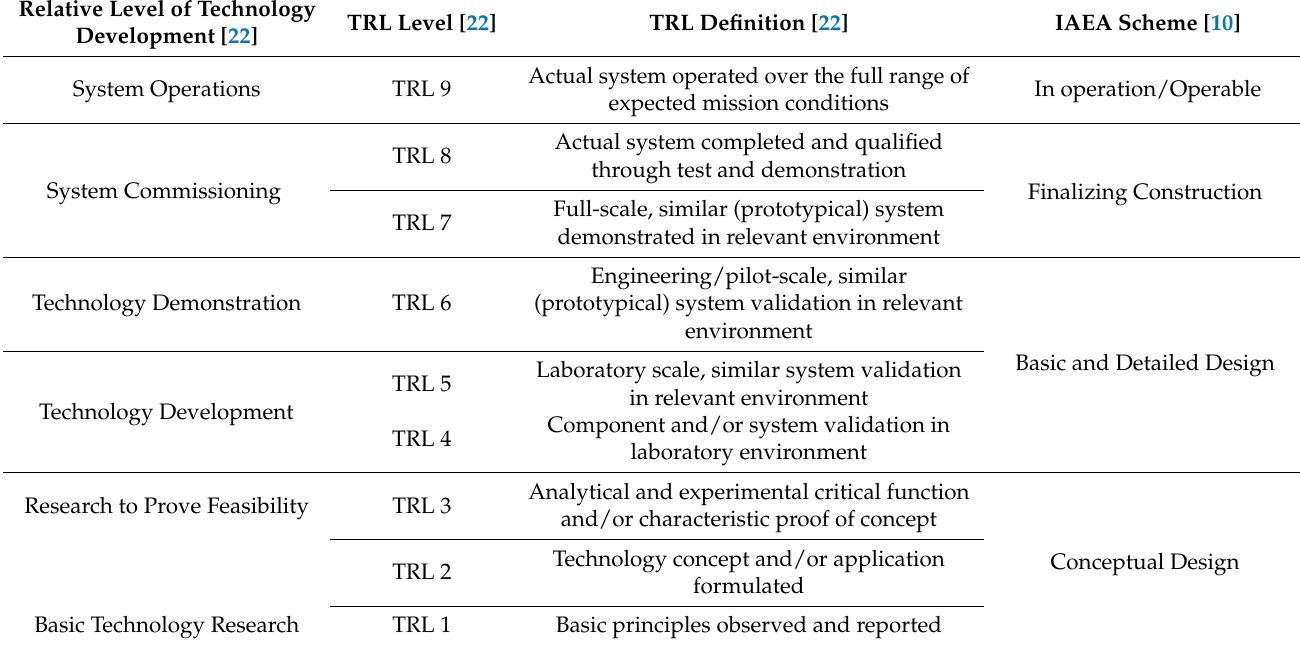
Table 1. Measures of technology